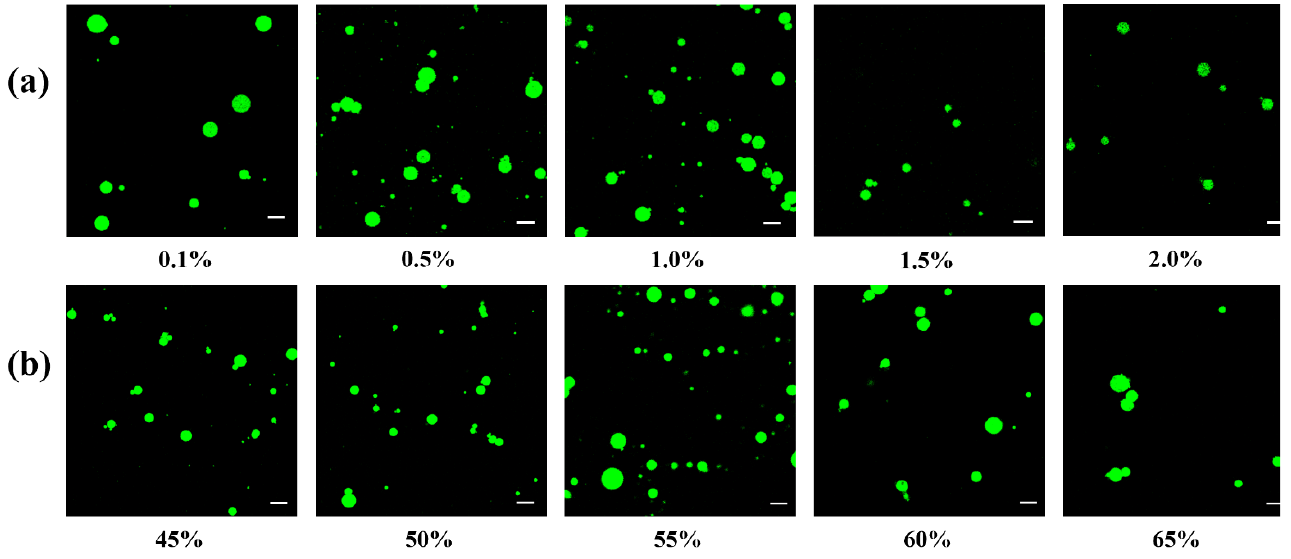
Figure 7. Morphology of Pickering emulsions stabilized with different particle concentrations ( a ) and oil fractions ( b ). The scale bar is 10 μ m.